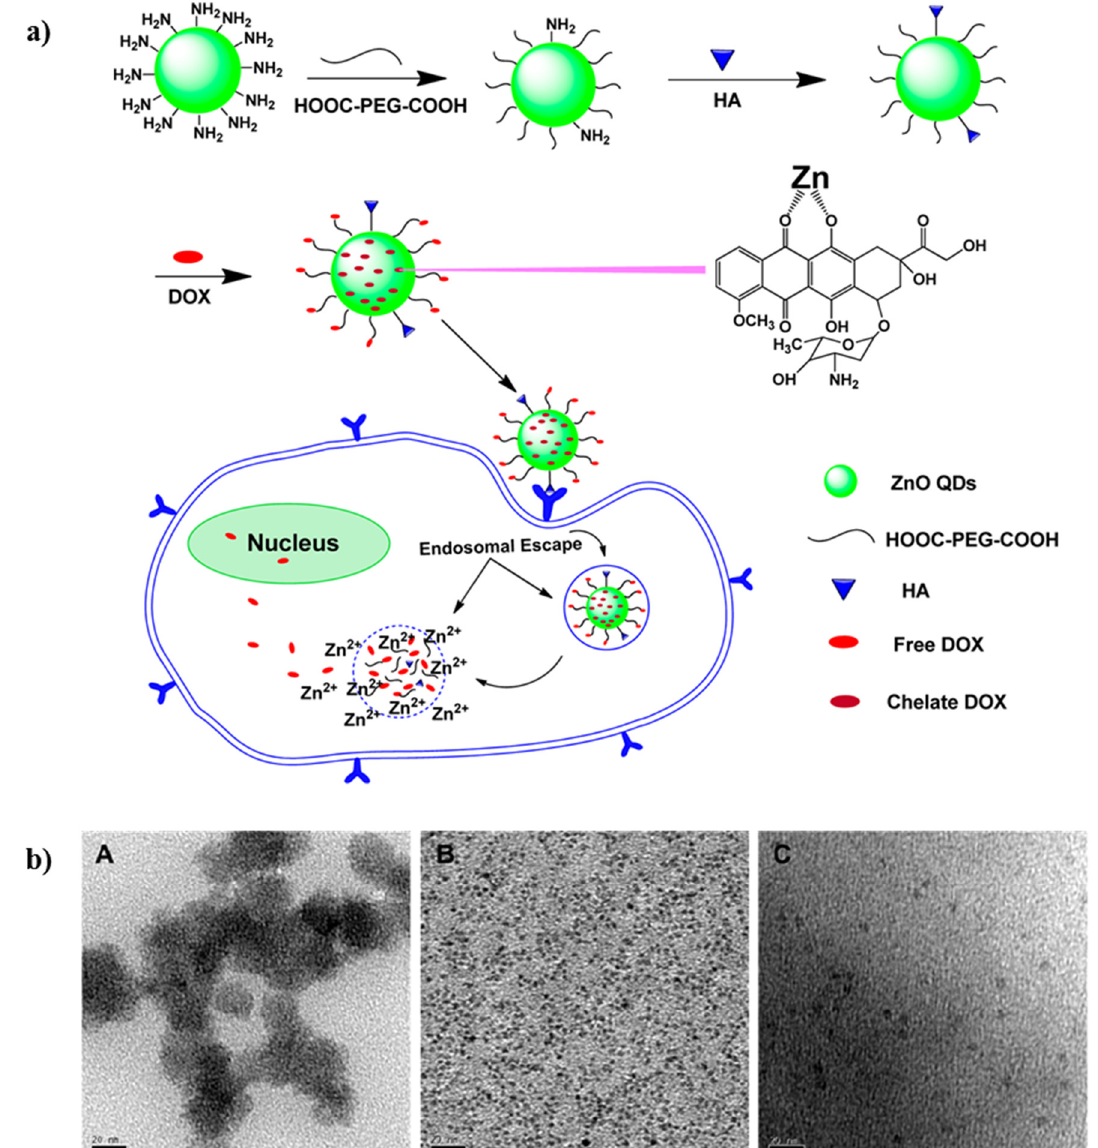
Figure 15. ( a ) Synthetic pathway and assay of working protocol of the Hyaluronic Acid (HA)-ZnO QDs-Dicarboxyl-Terminated PEG drug delivery system. ( b ) TEM images of: ( A ) ZnO QDs, ( B ) NH 2 -ZnO QDs, and ( C ) PEG-ZnO QDs. The scale bar represents 20 nm. Reprinted with permission from [99]; copyright (2016) American Chemical Society.